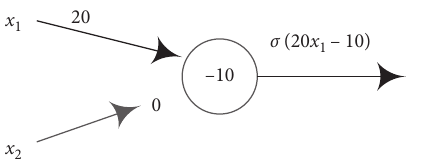
Figure 5: Sigmoid neuron with one input, with weight 20, and an overall bias of − 10.